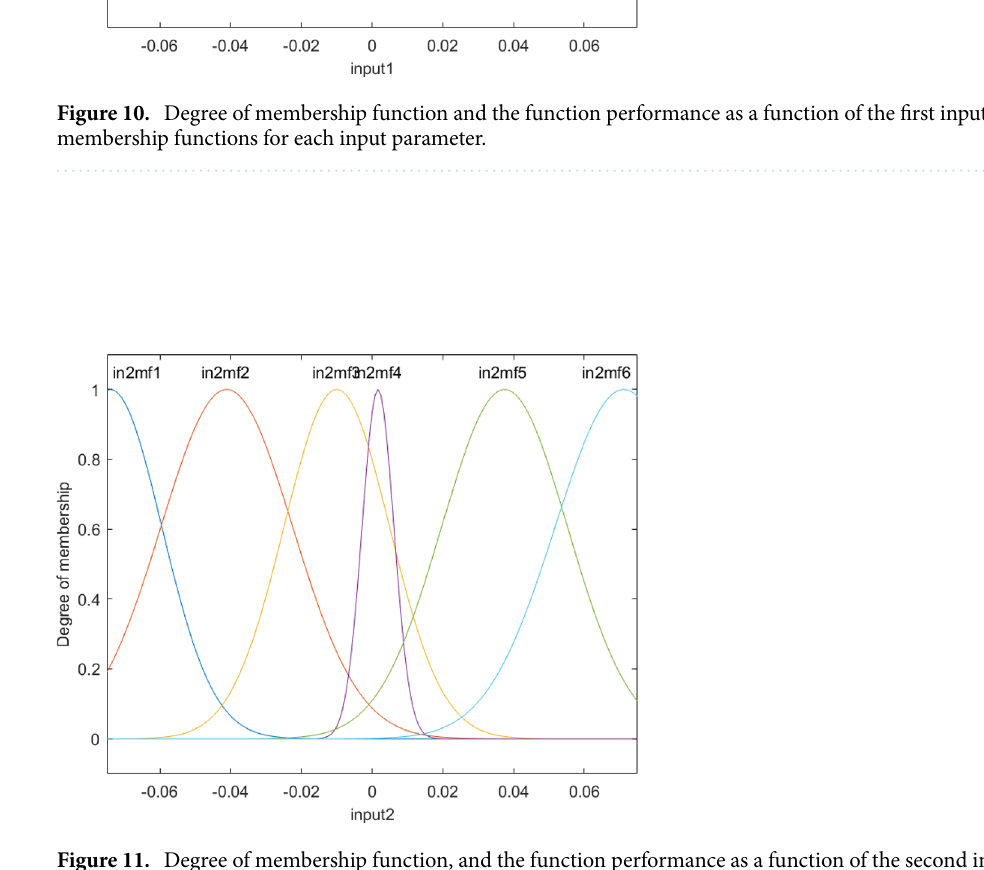
Figure 11. Degree of membership function, and the function performance as a function of the second input for six membership functions for each input